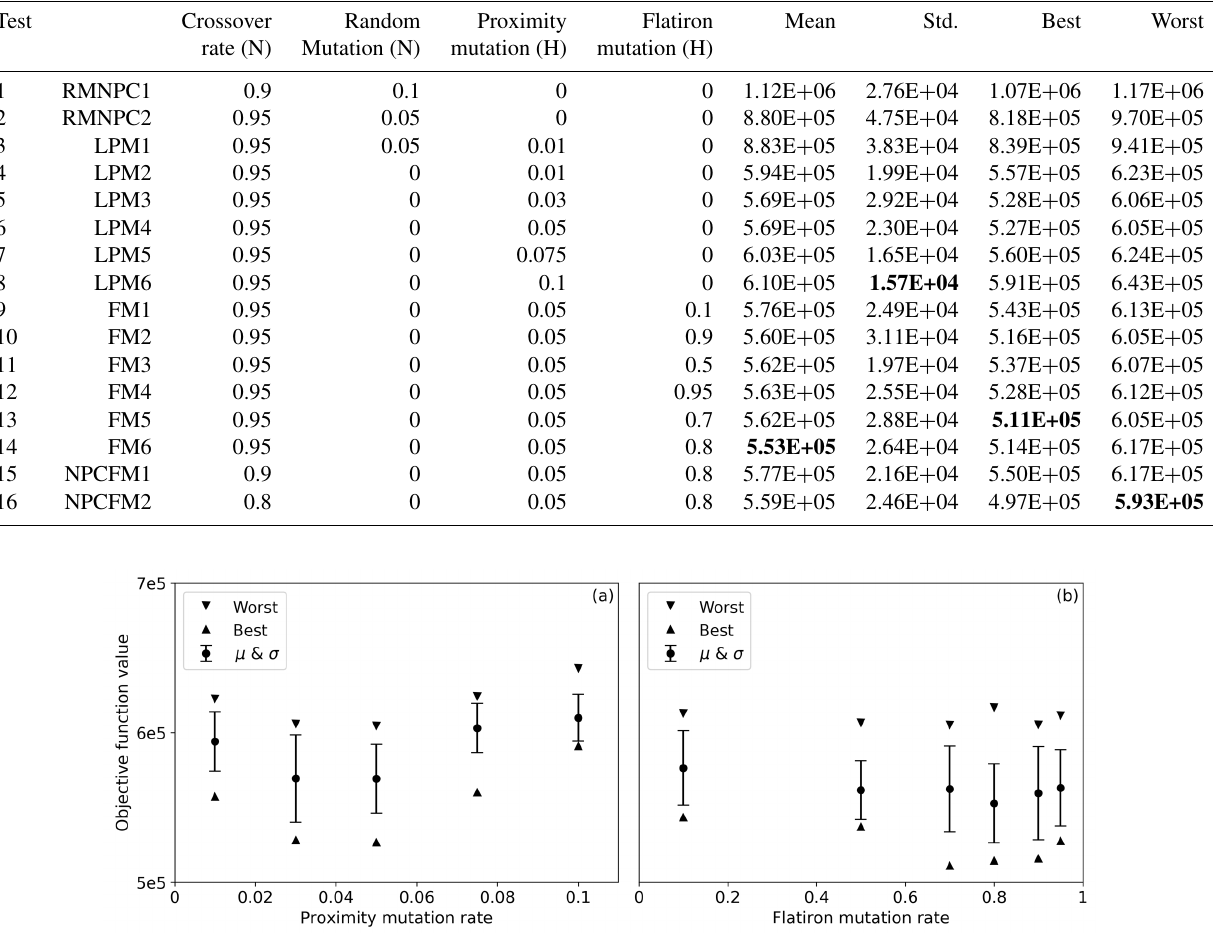
Table 2. Problem-specific variator values considered in the different tests and obtained results for 10 runs with 1 × 10 5 function evaluations each. The best results are indicated in bold.